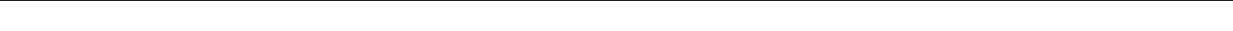
Fig. 2 Identi fi cation of candidate genes involved in cortical development via PB-based insertional mutagenesis. a The procedure used for the genetic screening. Cortical and ectopic layers containing cells electroporated with PB/PBase (red) at E14.5 were isolated surgically at P10. Genomic DNA (gDNA) was then extracted for splinkerette PCR to identify the insertion sites. b The products of the splinkerette PCR from four different mouse brains separated by agarose gel electrophoresis. Each prominent band (arrowheads) was excised for DNA sequencing. c Distribution of PB insertions within 50 kb of known genes in the mouse genome. Percentage of the PB insertions located in exons, introns, 5 ′ intergenic regions and 3 ′ intergenic regions are shown. d IPA was used for the functional categorization of the candidate genes. The area of each rectangle represents the p -value of a particular gene relevant to a particular functional pathway. The results show that these genes are mainly involved in development and nervous system functions. e A Circos diagram illustrating the positions of the identi fi ed candidate genes within the mouse genome and the type of insertion (intron and exon). Genes involved in three pathways were also linked together; these were genes involved in abnormal morphology of the brain, head and nervous system (yellow strings), genes involved in abnormalities of the craniofacial area, rhombencephalon and telencephalon (blue strings), and genes involved in cell movement of embryonic cells as well as cell – cell adhesion (red